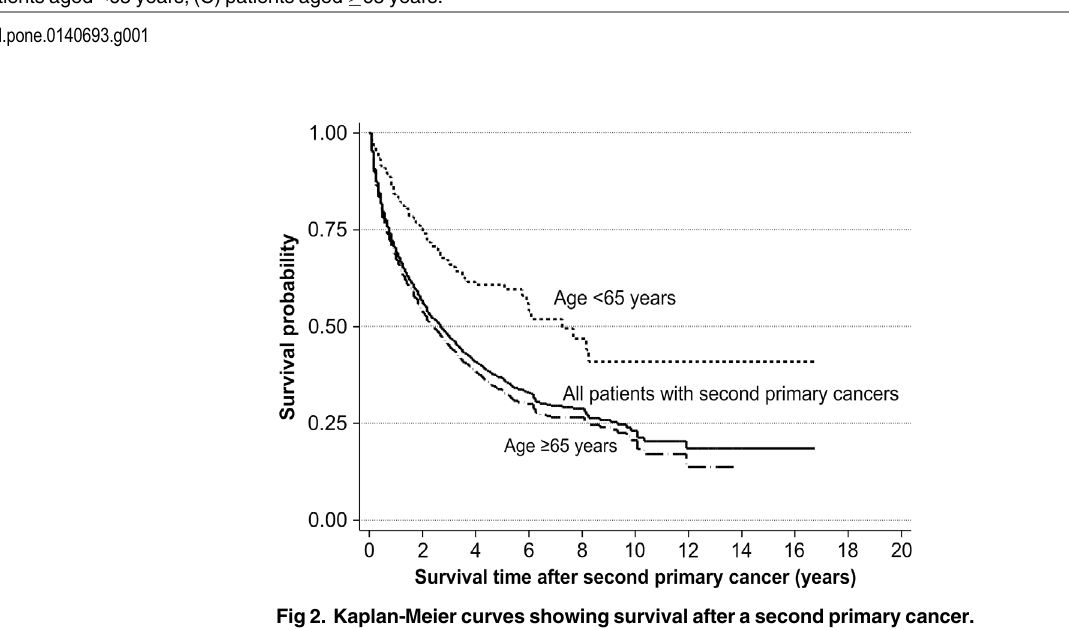
PLOS ONE | DOI:10.1371/journal.pone.0140693 October 15,